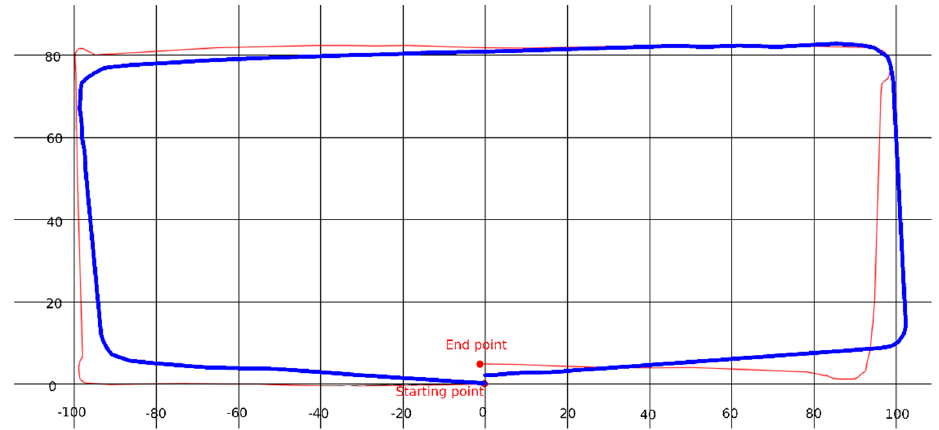
Figure 4. Evaluation of odometry measurements using the optical encoders.